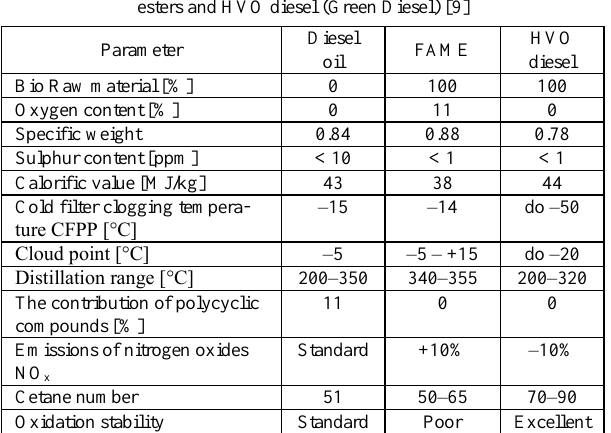
Table 2. Comparison of properties of diesel oil, FAME fatty acid methyl esters and HVO diesel (Green Diesel) [9] Parameter